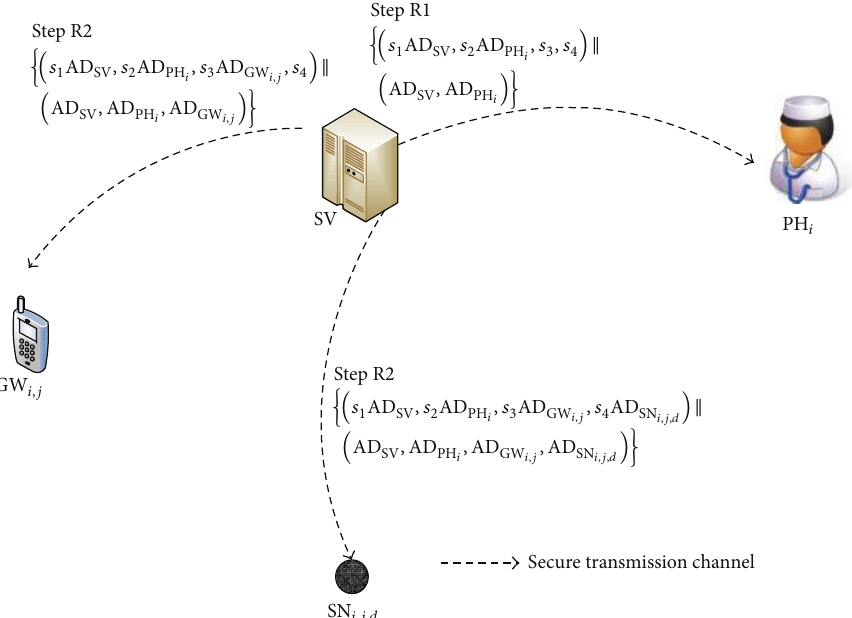
Figure 2: Physician and patient registration phase in Kim’s paper